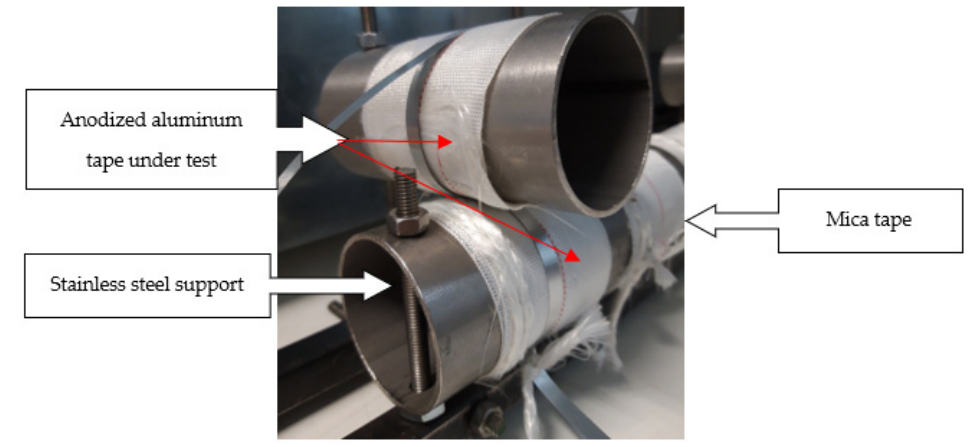
Figure 3. Crossed samples configuration.